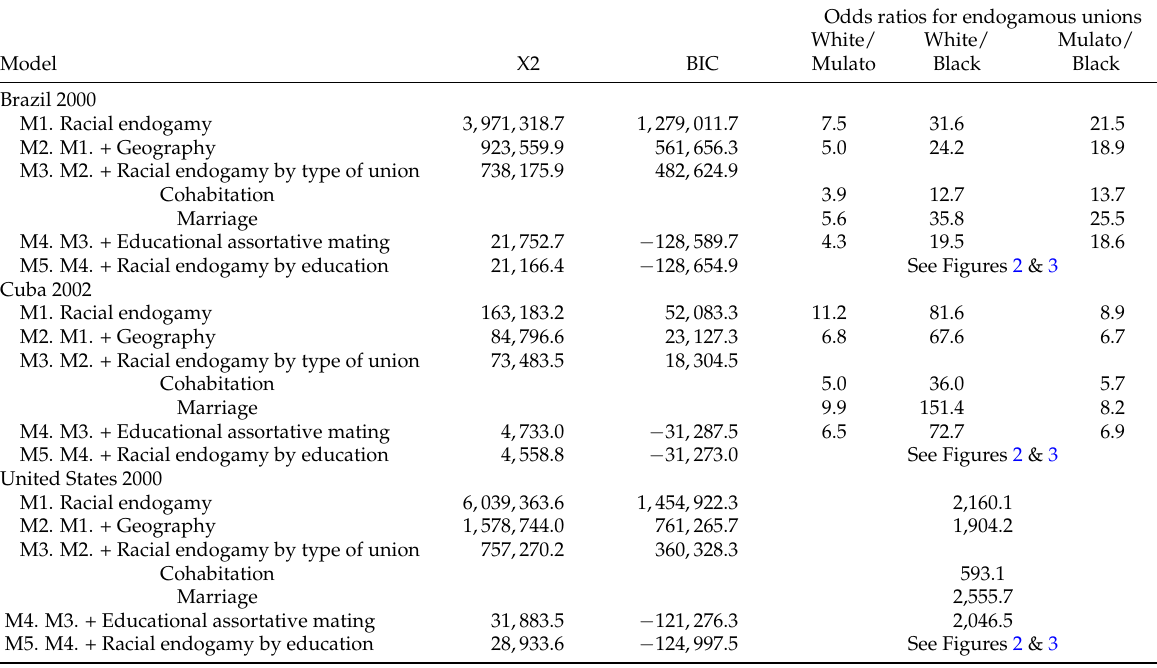
Odds ratios for endogamous unions White/ White/ Mulato/